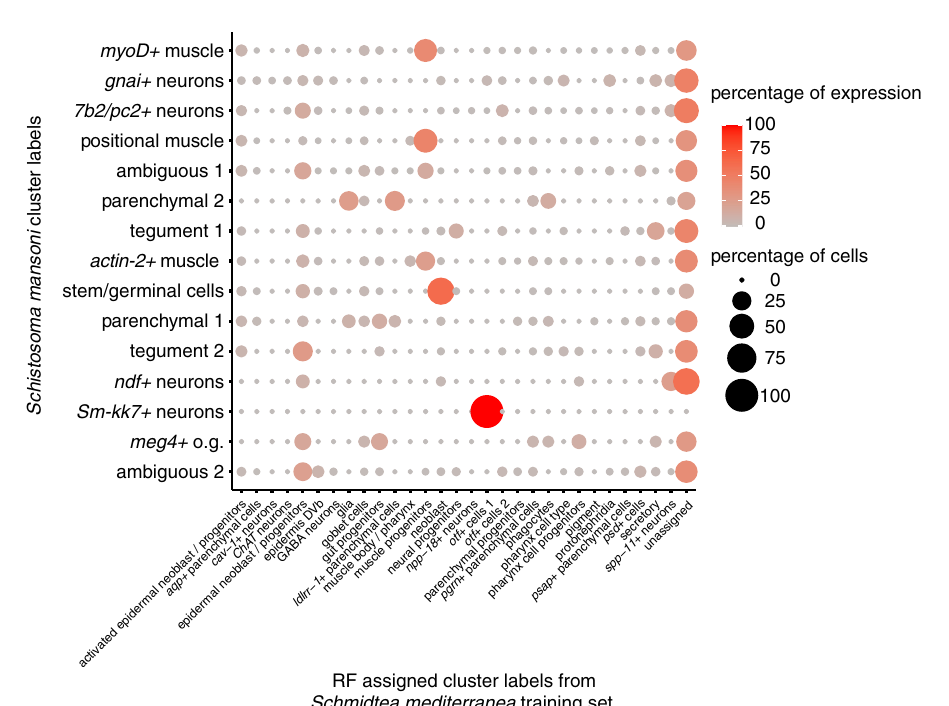
Fig. 7 Gene-expression patterns of stem cells and neurons conserved between S. mansoni and Schmidtea mediterranea . Random forest classi fi er used to assign cells from schistosomulum clusters into categories based on a Schmidtea mediterranea scRNAseq dataset 32 . The colours and size of the circles represent the proportion of cells from each cluster ( y -axis) that matches each S. mediterranea category label ( x -axis). Only categories that received a maximum vote by a margin of >16% of trees during the prediction are included. Cells that did not fi t any classi fi cation were classed as ‘ not assigned ’